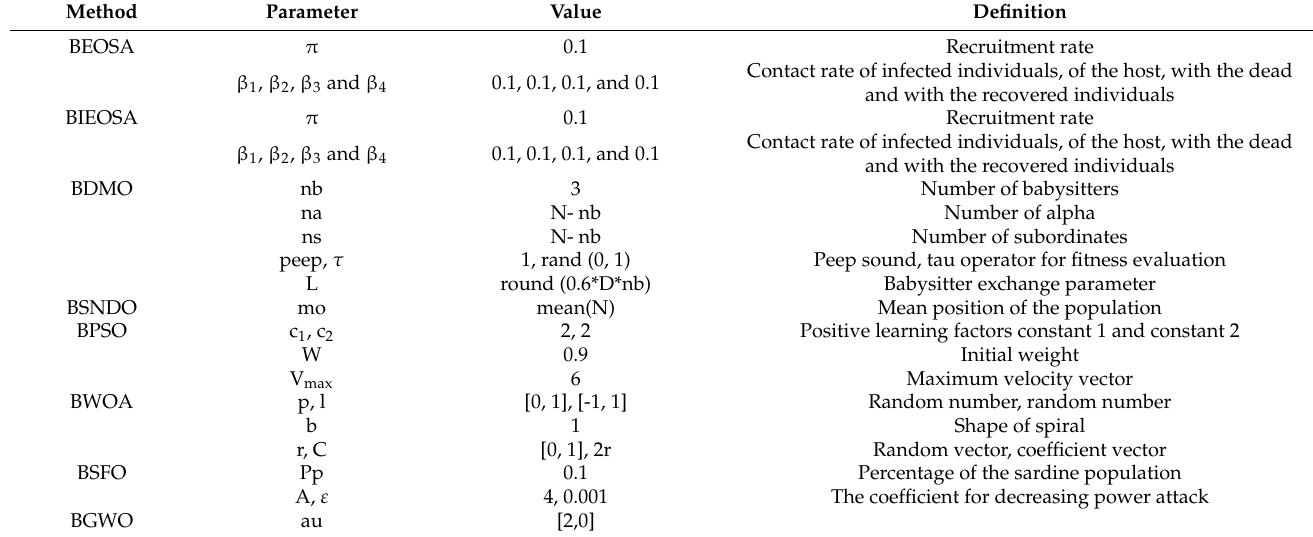
Table 2. Parameters for the BEOSA, BIEOSA, BDMO, BSNDO, BPSO, BWOA, BSFO and BGWO metaheuristic algorithms in this study. N, as used for BDMO and BSNDO, denotes the population